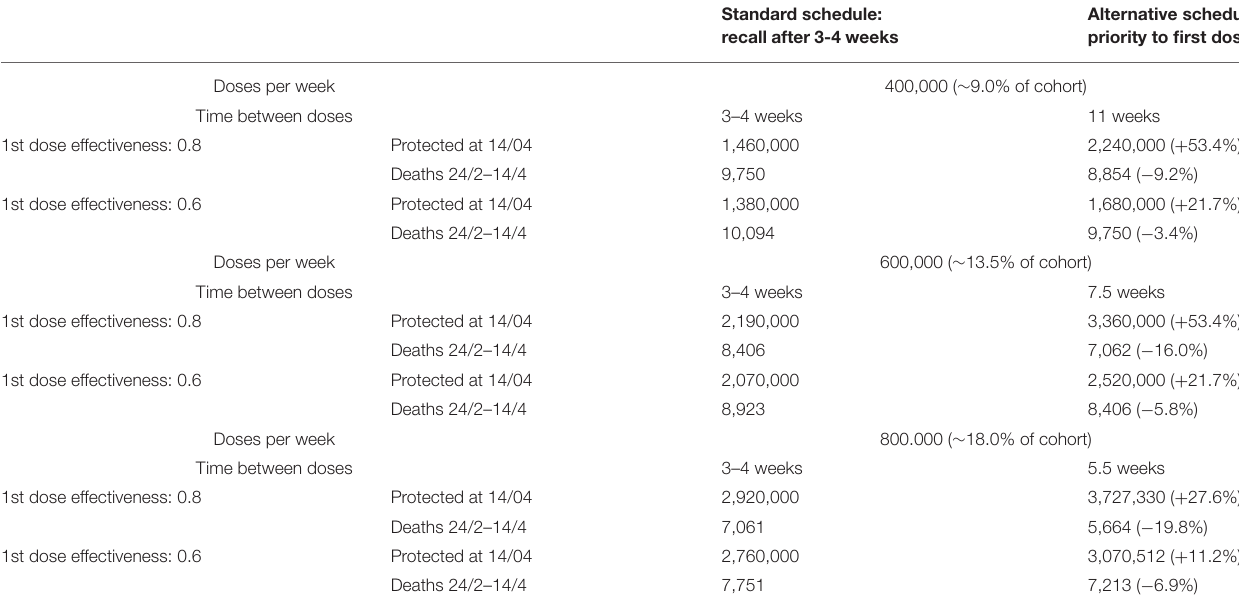
TABLE 1 | Comparison between standard and alternative schedule.